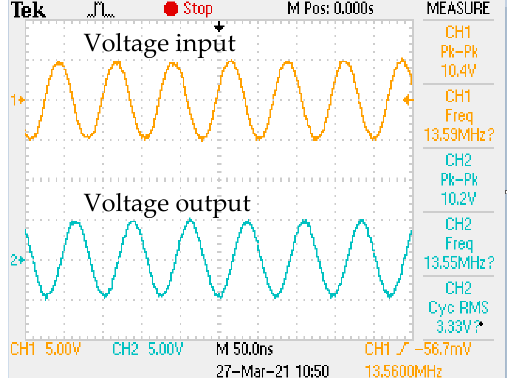
Figure 21. Voltage at the load of the S-CPT system.